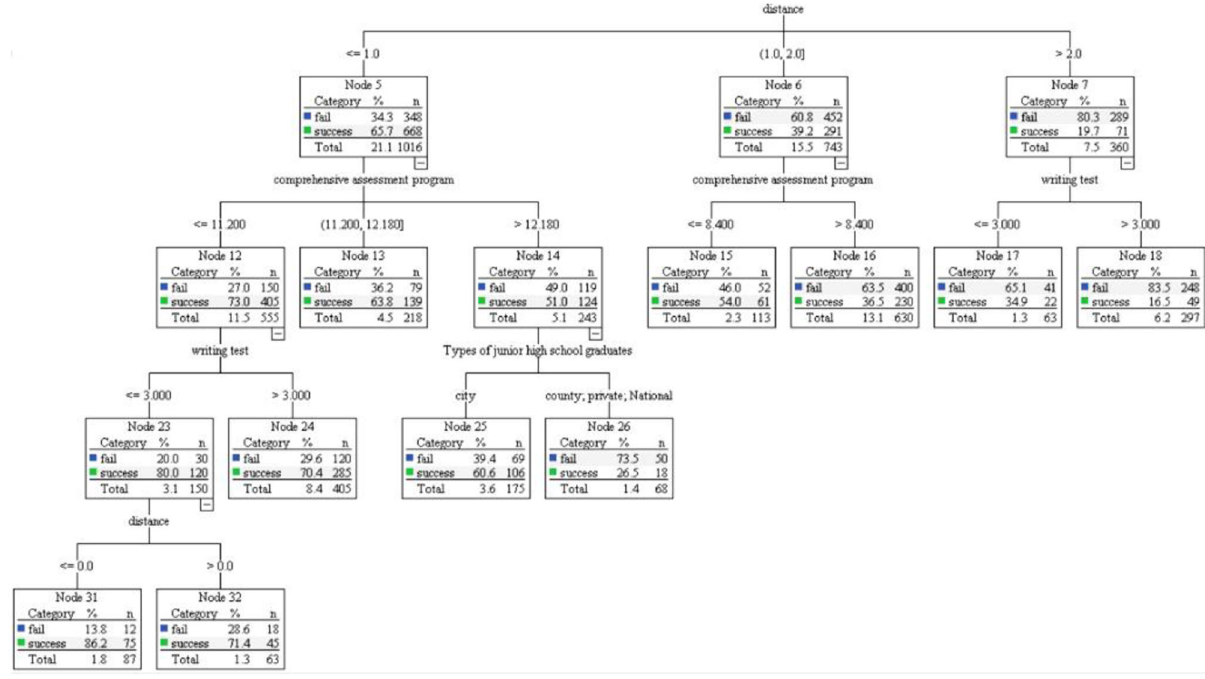
Fig. 7 A sub-tree on right for the training. A sub-tree structure for the training sample in the agricultural county colleges.